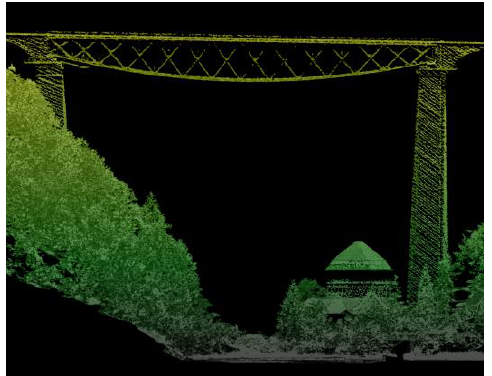
Figure 4: Profile view of a LiDAR point cloud from a Leica TerrainMapper-2, with a conical scan pattern. The result shows the enhanced details on vertical surfaces and even on the structures under the bridge deck.